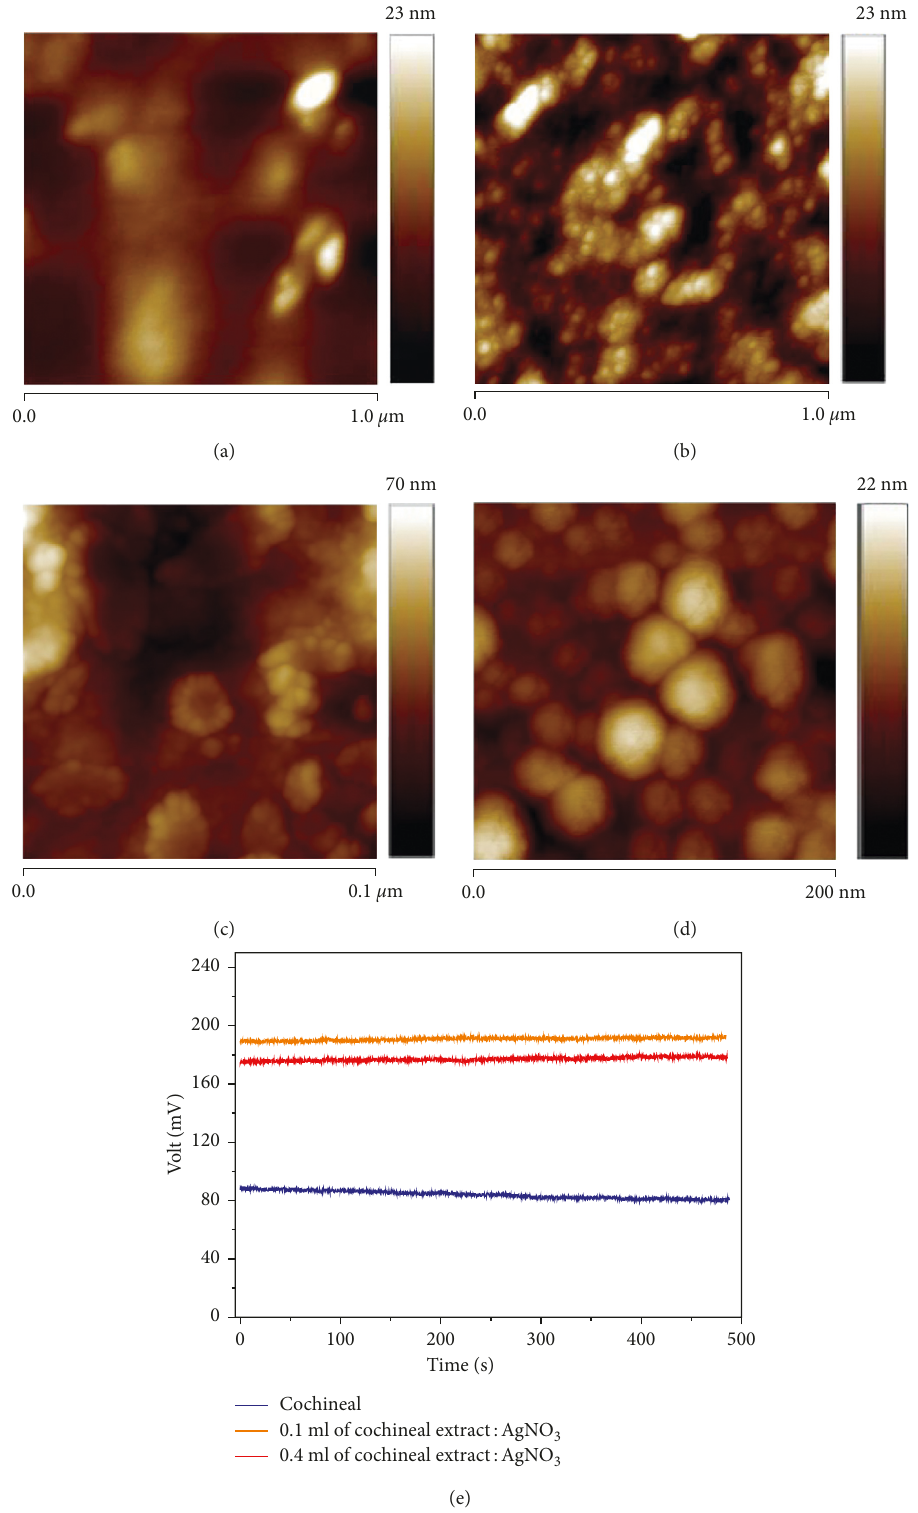
Figure 7: Atomic force micrographs of 1 1 µ m 2 thin films (on glass) of (a) cochineal pigment and AgNPs synthesized with (b) 0.1ml and × (c) 0.4ml of cochineal extract solution. (d) Atomic force micrograph of 200 200 nm 2 from the same batch as shown in (c). Electric potential × curves (e) as a function of time of cochineal pigment and AgNPs (0.1 and 0.4ml of the cochineal